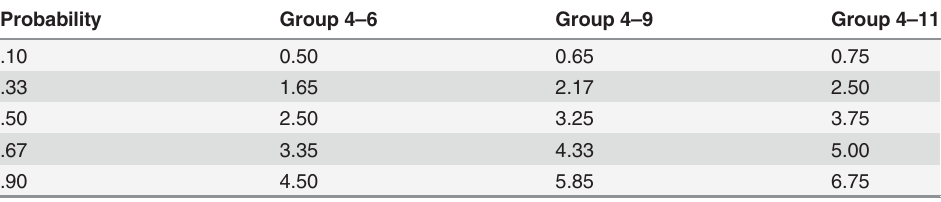
Table 2. Expected value of the high-uncertainty choice as a function of the probability of food for a high-uncertainty choice for each group in Experiment 2.